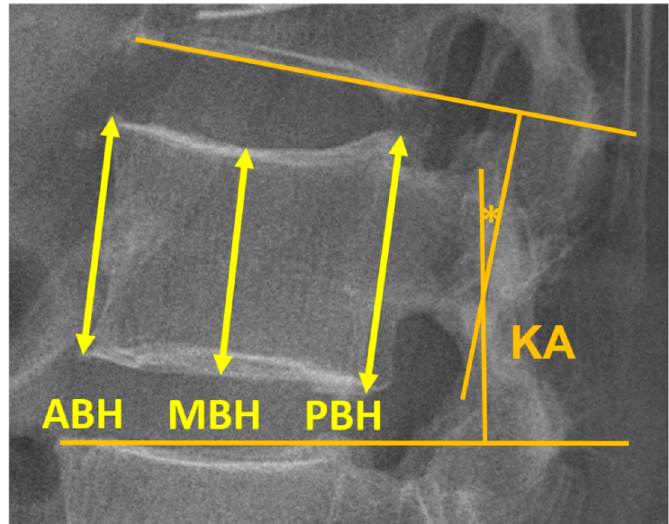
Figure 1. Radiological outcome measurements. ( ABH anterior body height, MBH middle body height, PBH posterior body height, KA kyphotic